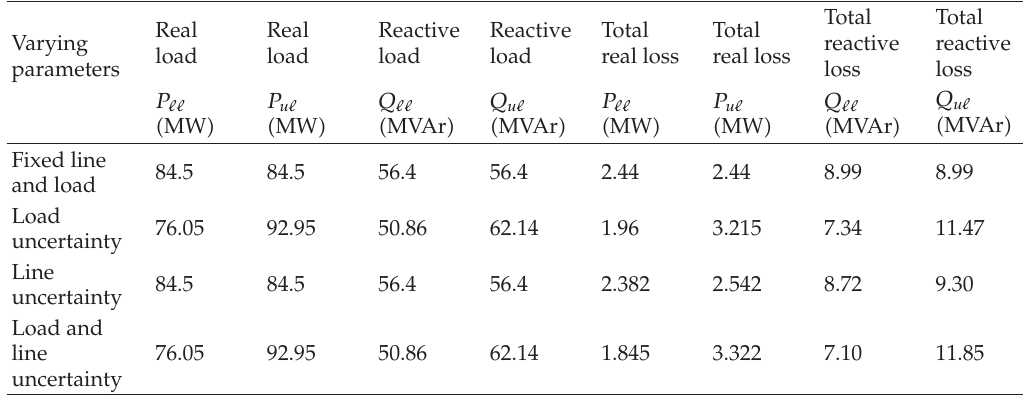
Table 4: Base case for Cases 1 and 2.